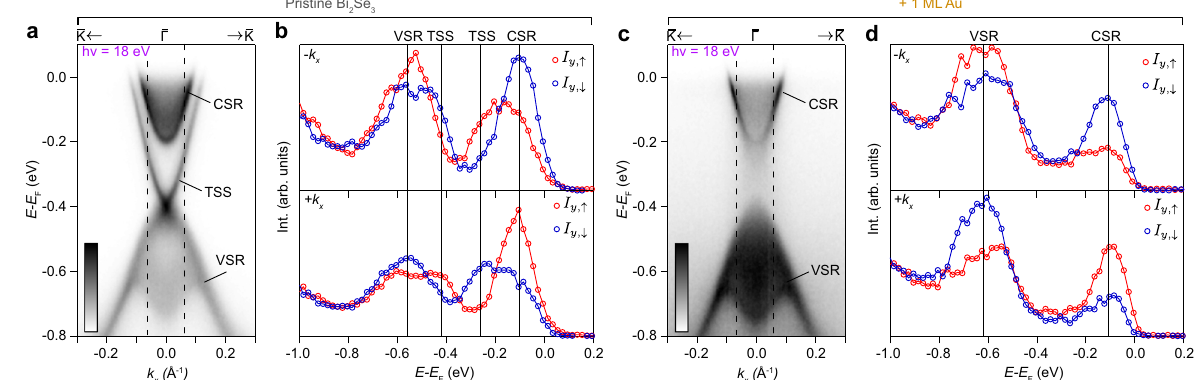
Fig. 4 Robust spin texture of the topological surface state and surface resonances. a Near- E F electronic structure of pristine Bi 2 Se 3 , as seen with 18 eV photons. The dashed lines indicate the momentum positions of the spin-resolved energy-distribution curves (EDCs) shown in b . b Spin-resolved EDCs for the in-plane chiral spin component ( S y ) (positions indicated in a through the conduction band surface resonance (CSR), valence band surface resonance (VSR) and the topological surface state (TSS). c Equivalent spectrum to that shown in a , but following Au deposition. Only the CSR and VSR states remain. The dashed lines indicate the momentum positions of the spin-resolved EDCs in d . d Spin- resolved EDCs through the TSS and the surface resonance states following 1.0 ML Au deposition, establishing that the chirality of the SR states is unchanged from that of the pristine sample. Colour scales for photoemission intensity run from low (white) to high